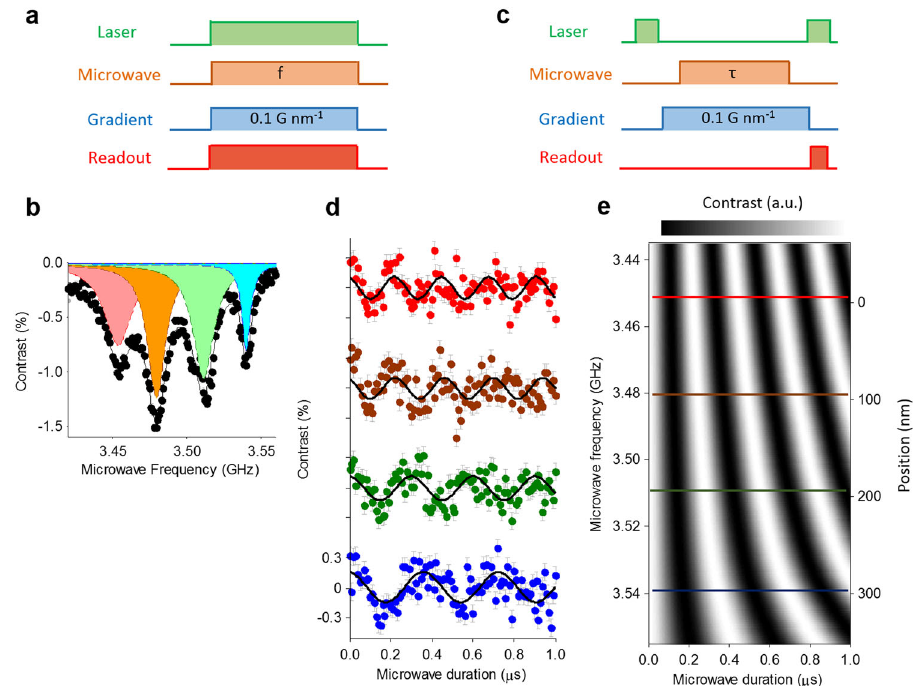
Fig. 2 Site-selective NV ESR and Rabi oscillations. a Site-selective NV ESR sequence featuring continuous NV spin-state optical initialization and readout, a swept-frequency microwave fi eld, and a fi xed magnetic fi eld gradient of 0.1 G nm − 1 (corresponding to I = 250 mA current). b Measured NV ESR spectrum with four resonance peaks, corresponding to each NV site in a 1 × 4 array. Black solid line is a fi t of the data ( black dots ) to a sum of four Lorentzian functions. The full-width-half-maxima of the peaks ≈ 8 – 15 MHz, and contrast ≈ 1.0 – 1.5%. c Site-selective NV Rabi driving sequence. Green laser pulses (5 μ s duration) initialize and read out the NV spin states. A fi xed magnetic fi eld gradient (0.1 G nm − 1 ) differentiates the ESR frequencies at the four NV sites via Zeeman shifts. A microwave pulse, with frequency tuned to any one of the four ESR resonances, drives Rabi oscillations at the corresponding NV site. Error bars indicate 68% con fi dence intervals in b and c . d Measured site- selective Rabi oscillation contrast as a function of microwave pulse duration τ MW . Black solid lines are fi ts of the data ( coloured dots ) to a sinusoid. From top to bottom, NV sites are driven at microwave frequencies of 3.452, 3.480, 3.511, and 3.540 GHz, with Rabi frequencies determined from fi ts to be 4.4(2), 4.2(2), 3.3(2), and 2.7(1) MHz, respectively. The Rabi frequency variation between sites is attributed to microwave fi eld inhomogeneity caused by the boundary conditions of the gradient microcoil. e Simulation with COMSOL of NV Rabi oscillation parameters provided by the gradient microcoil. The calculated Rabi frequency variation is consistent with the measurements in